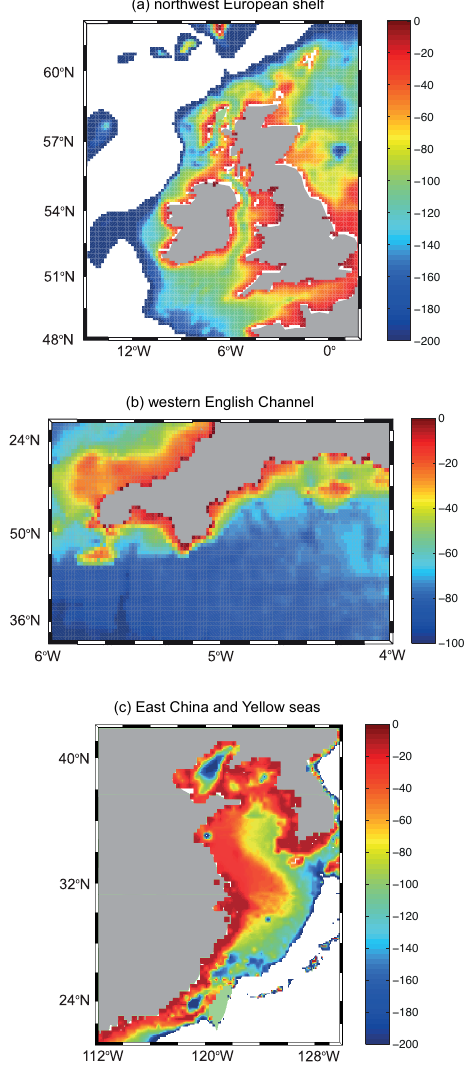
Figure 1. Bottom depth (relative to sea surface) in the three S2P3-R domains: (a) northwest European shelf; (b) western English Chan- nel; (c) East China and Yellow